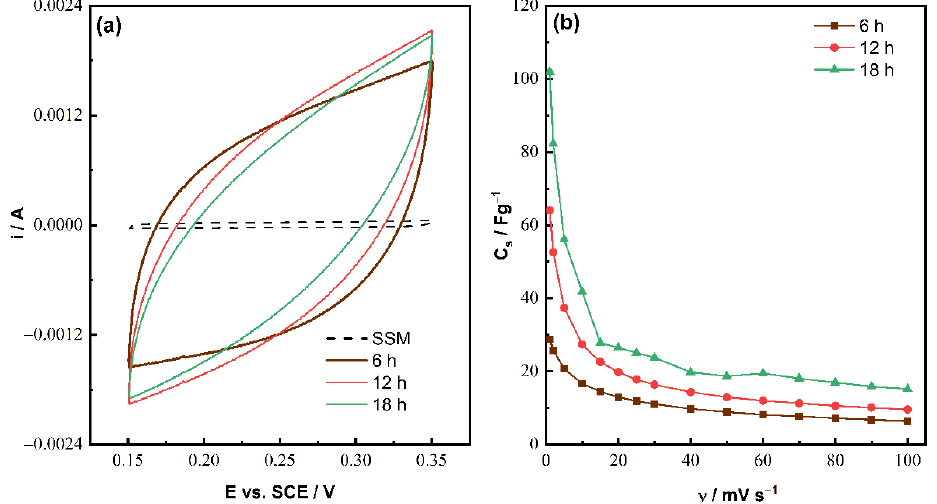
Figure 10. ( a ) CV curves at 10 mV s − 1 of ZnMn 2 O 4 samples prepared for 6 h, 12 h, and 18 h, and ( b ) variation of specific capacitance of ZnMn 2 O 4 samples as a function of the potential scan rate.